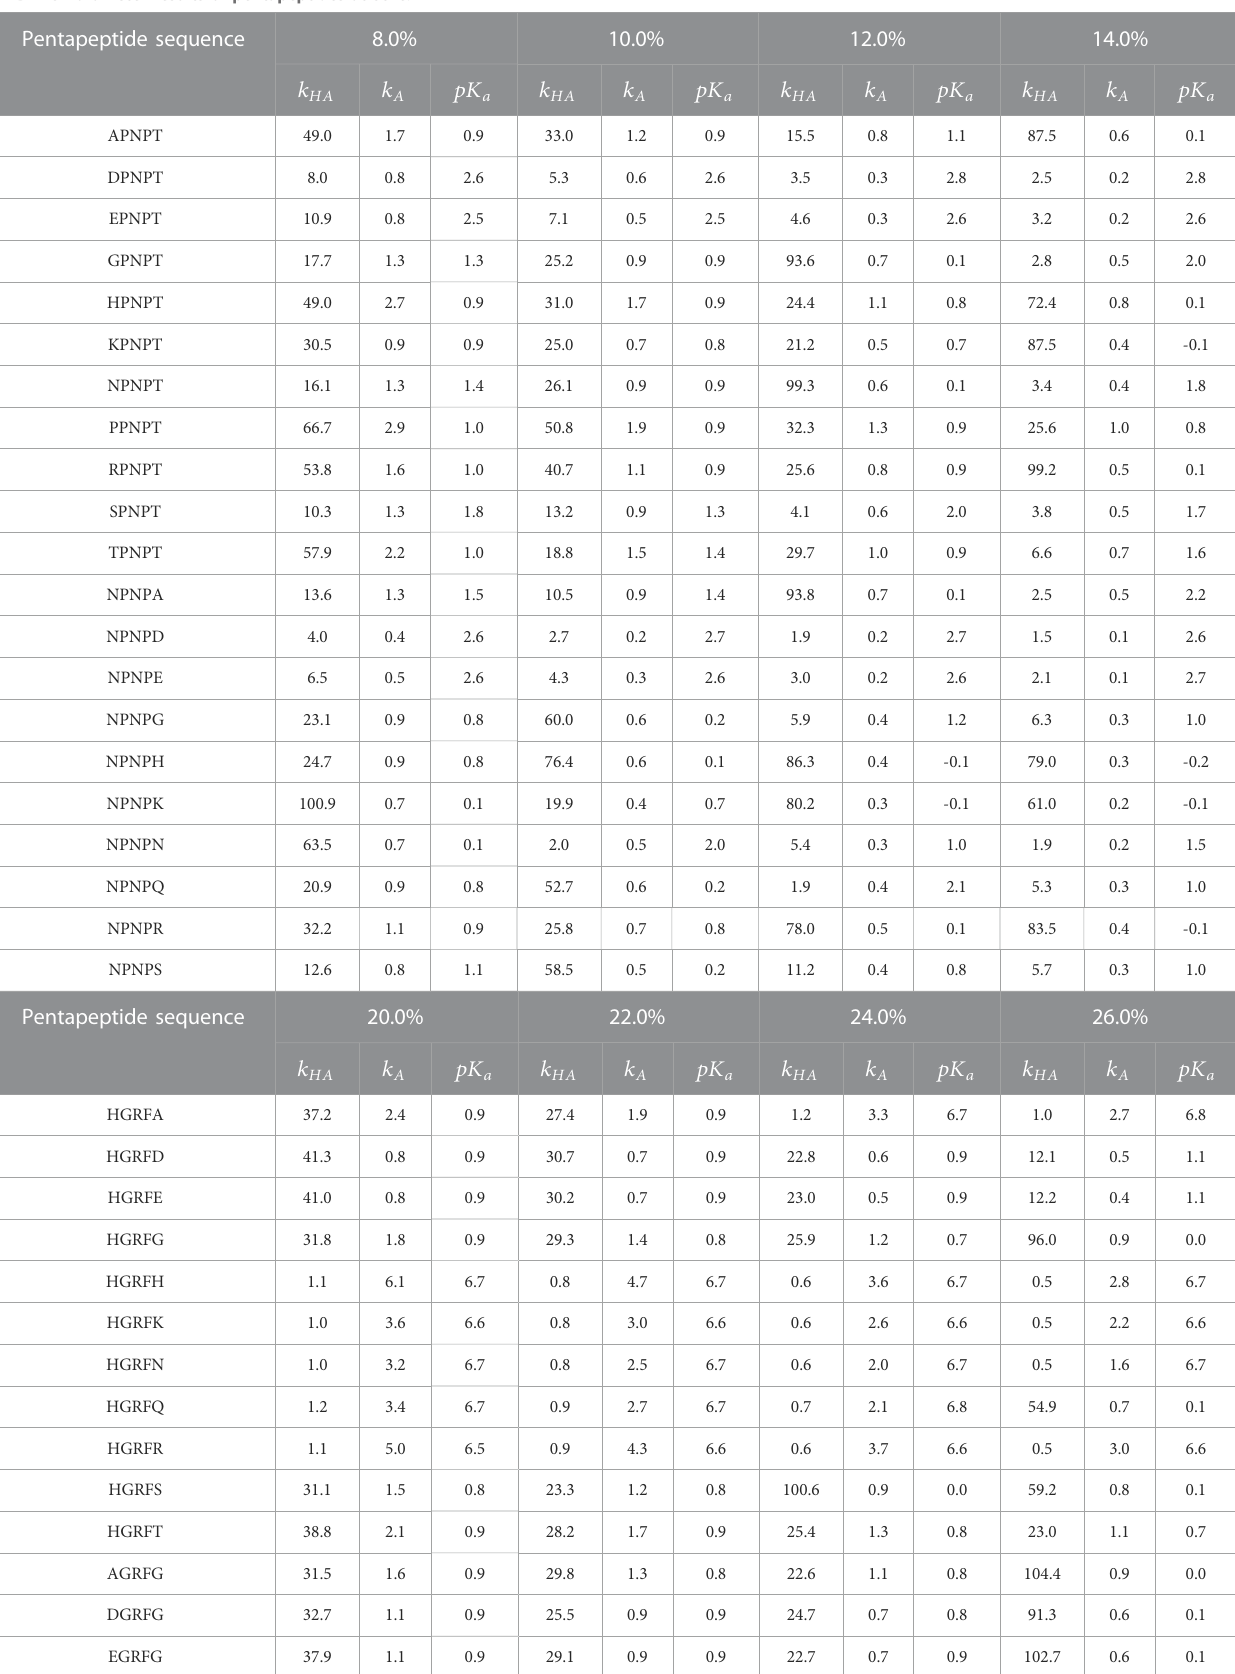
TABLE 3 Parameter results of pentapeptides at 35 ° C. Pentapeptide